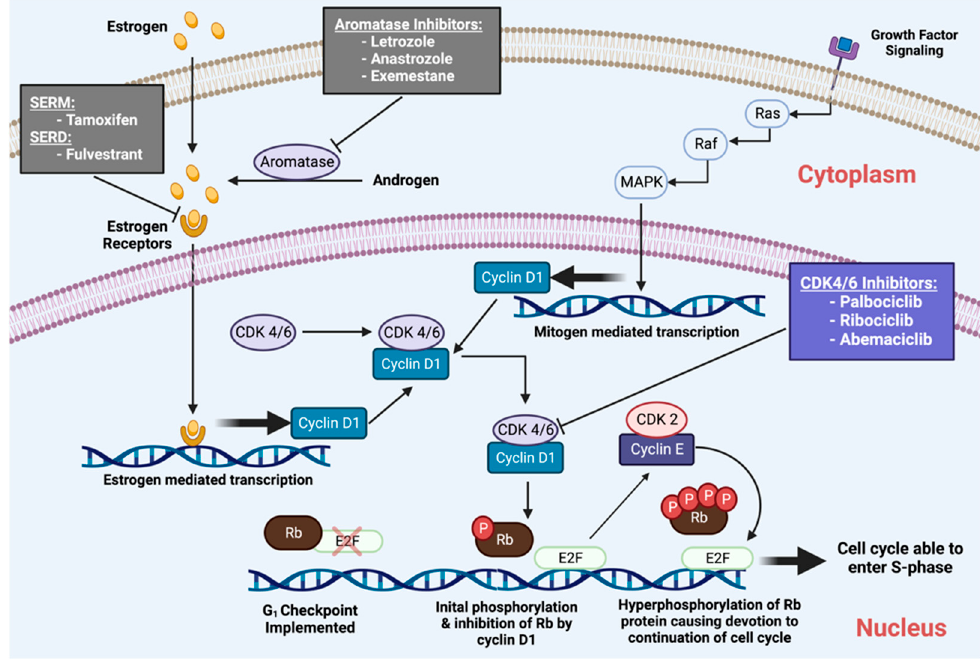
Figure 1. CDK in Breast Cancer therapy.